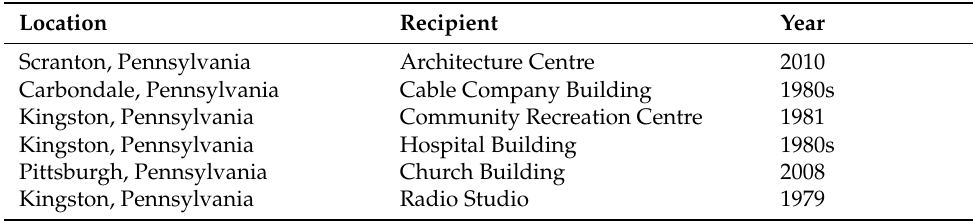
Table 1. Minewater geothermal energy systems in the USA detailed by Korb (2012) [41].